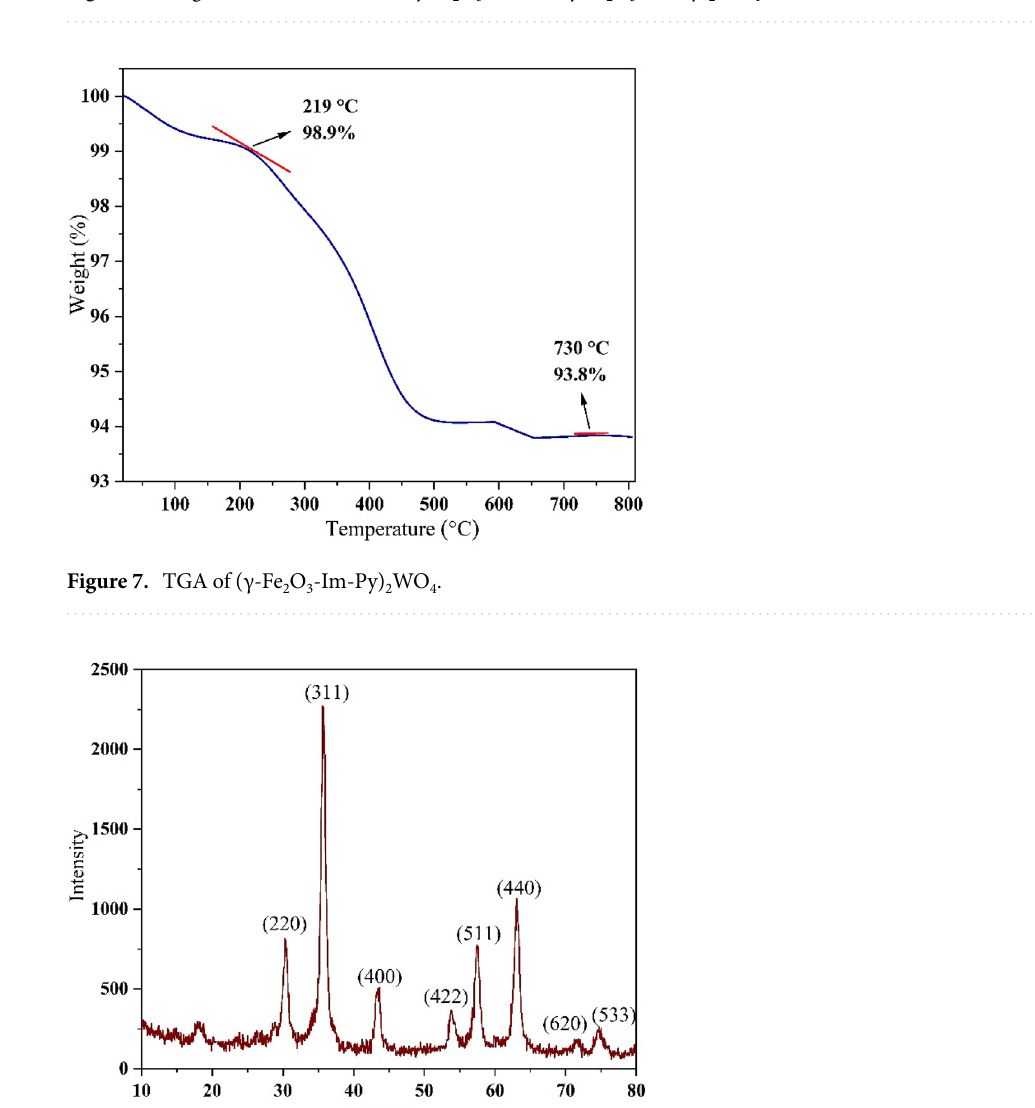
Figure 6. Magnetization curves of ( a ) γ-Fe 2 O 3 and ( b ) (γ-Fe 2 O 3 -Im-Py) 2 WO 4 .